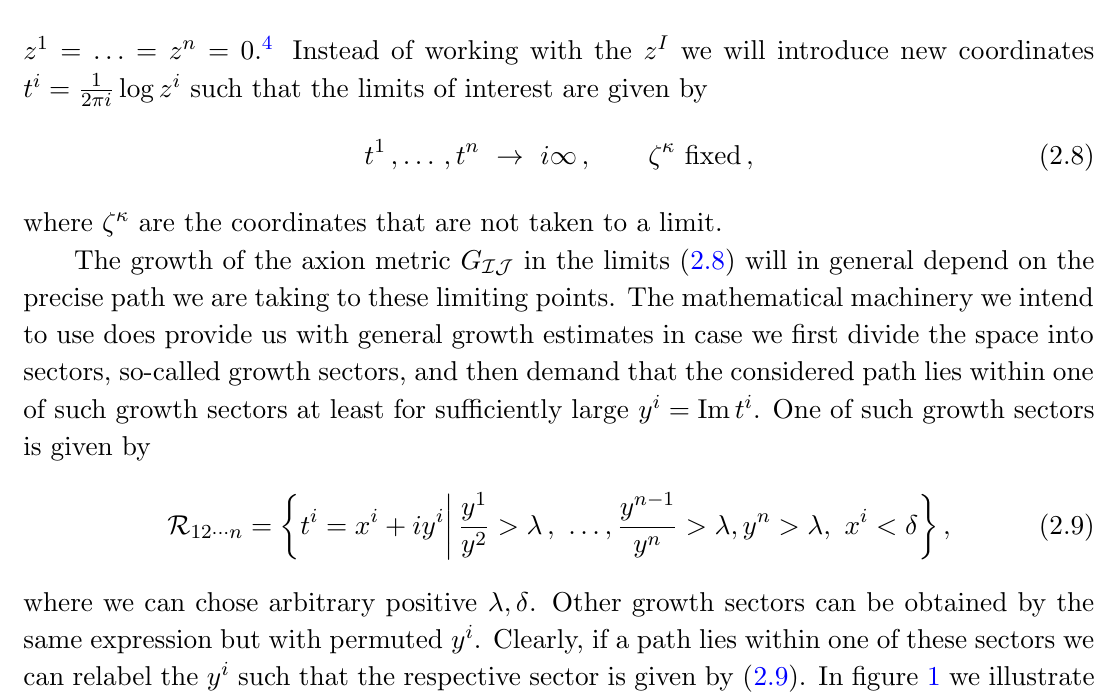
Figure 1 . Two paths (cid:13) 1 ; (cid:13) 2 towards the limiting point t 1 ! i 1 ( z 1 = 0) and t 2 ! i 1 ( z 2 = 0), respectively. The paths can lie in di(cid:11)erent growth sectors, since either the growth of y 1 or y 2 dominate in these cases. We also indicated the associate log-monodromy matrices N 1 ; N 2